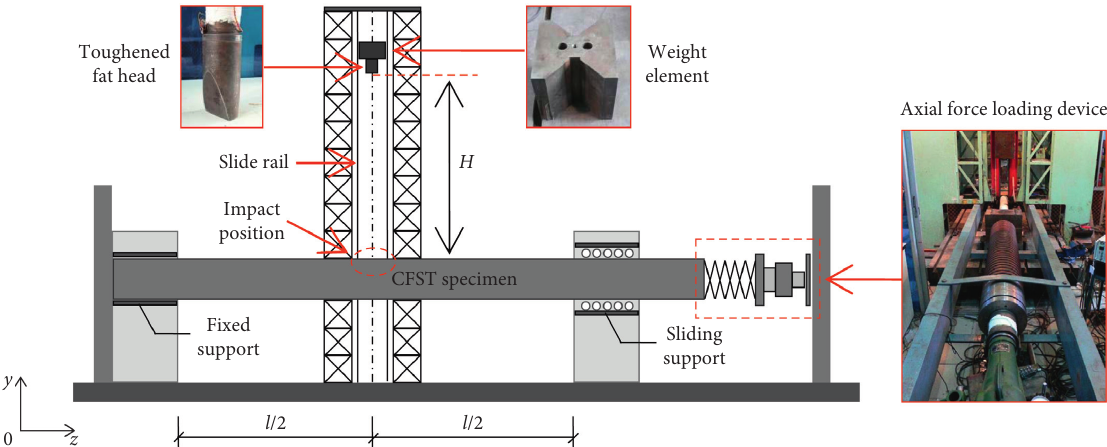
Figure 2: Sketch of test configuration